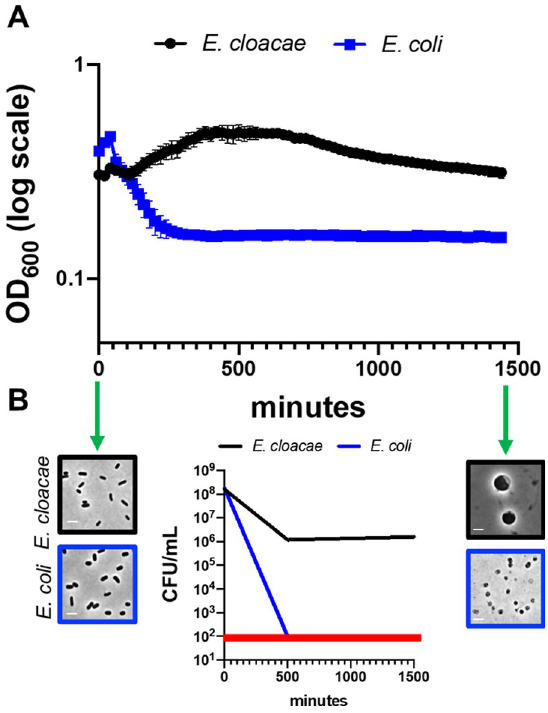
Fig 1. Enterobacter cloacae ATCC 13047 is highly meropenem tolerant. (A) Representative experiment demonstrating changes in OD 600 measurements following meropenem treatment in E . cloacae relative to E . coli . Error bars represent the average of 3 technical replicates +/- standard deviation. (B) Survival was calculated as CFU/mL from the experiment depicted in (A). The red line denotes the limit of detection. Phase images from the same experiment show cells before and after meropenem exposure to illustrate spheroplast formation in E . cloacae and lysis in E . coli (only cell debris is visible in phase image). Scale bars, 2 μ